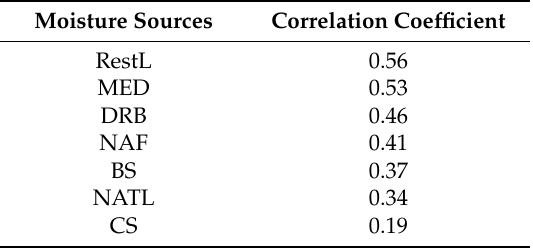
Table 5. Pearson correlation coefficients between the anomalies in the moisture supply from the sources to the DRB and SPEI-1 time series. Except for CS, all the values are significant at 99.9% according to the Student’s t